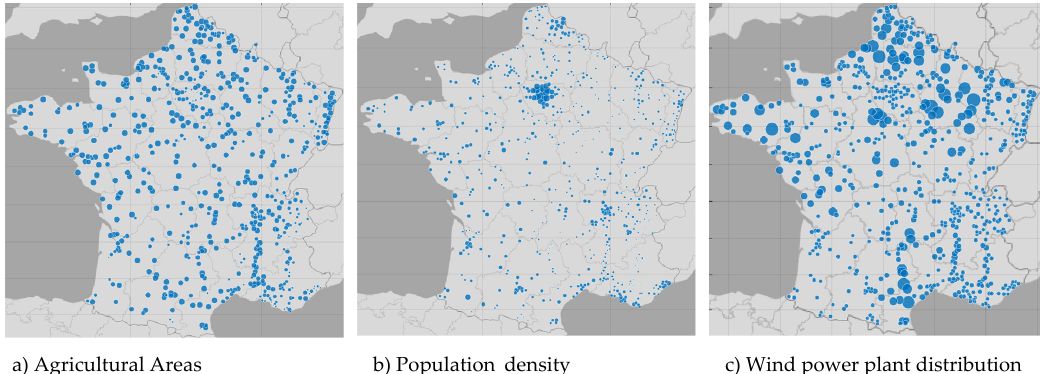
Figure 10. Methodology for spatial distribution of wind power plants in Figure 10: Methodology for spatial distribution of wind power plants in France 735